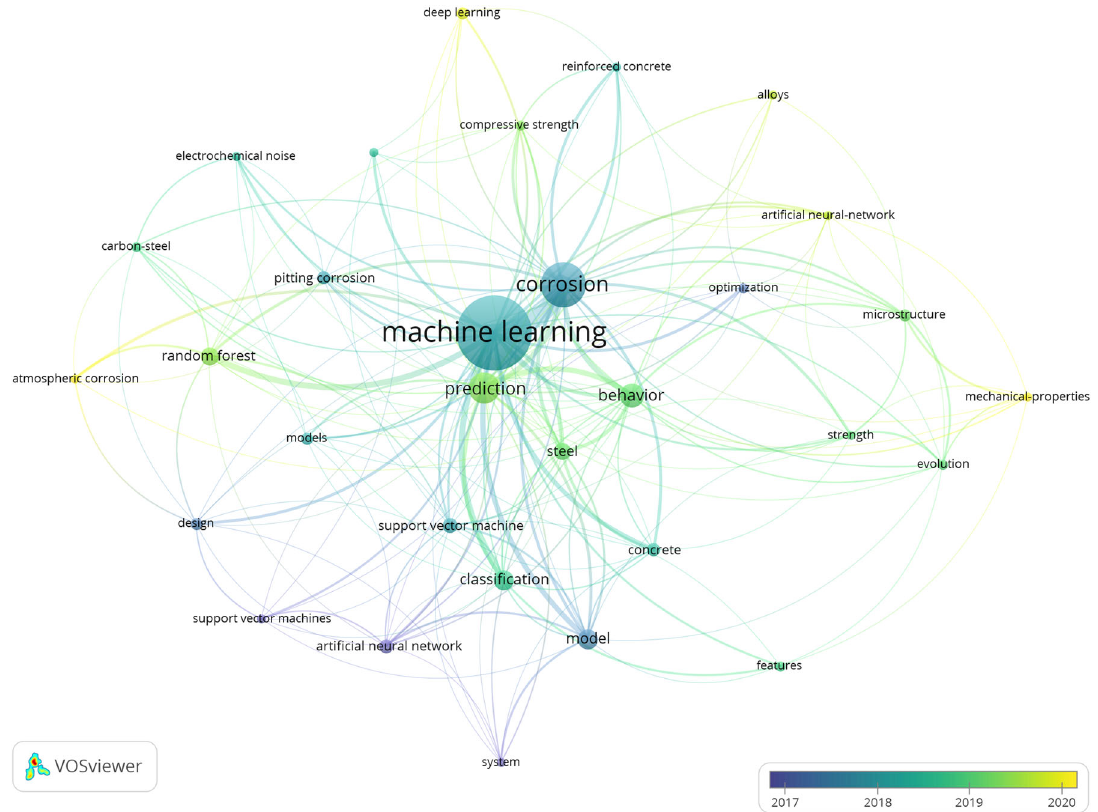
Fig. 1 Visualization of the co-citation network of ‘ machine learning ’ and ‘ corrosion ’ publications. Citation relations from 2017 to 2020 (VOSviewer 41